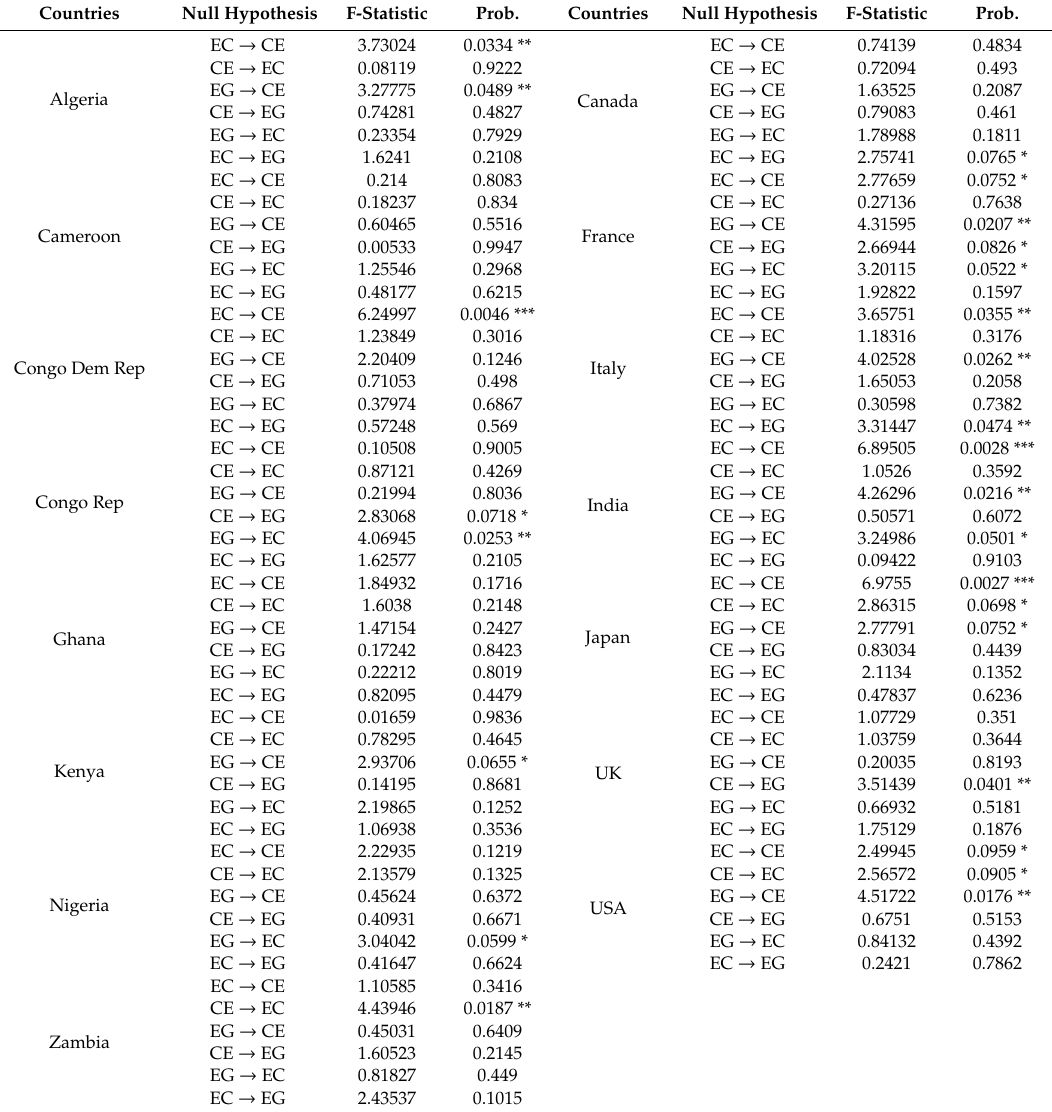
Table 5. Granger causality test